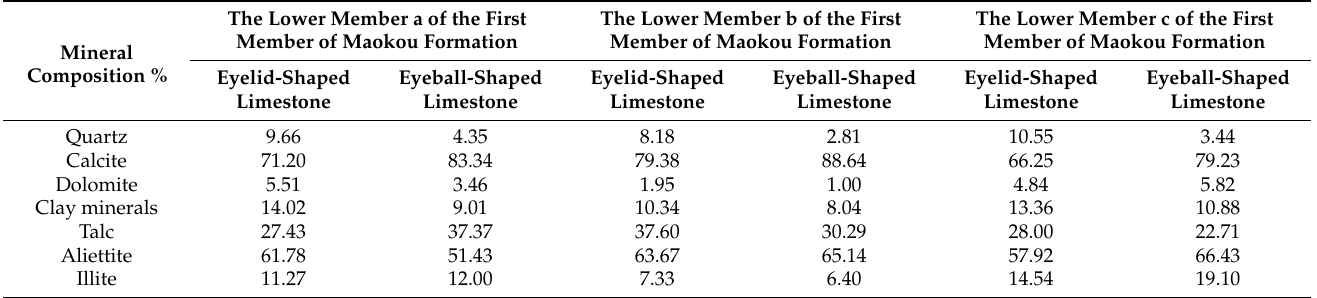
Table 1. Average statistical table of main mineral compositions of tight marl in the first member of Maokou Formation in Xintan Well